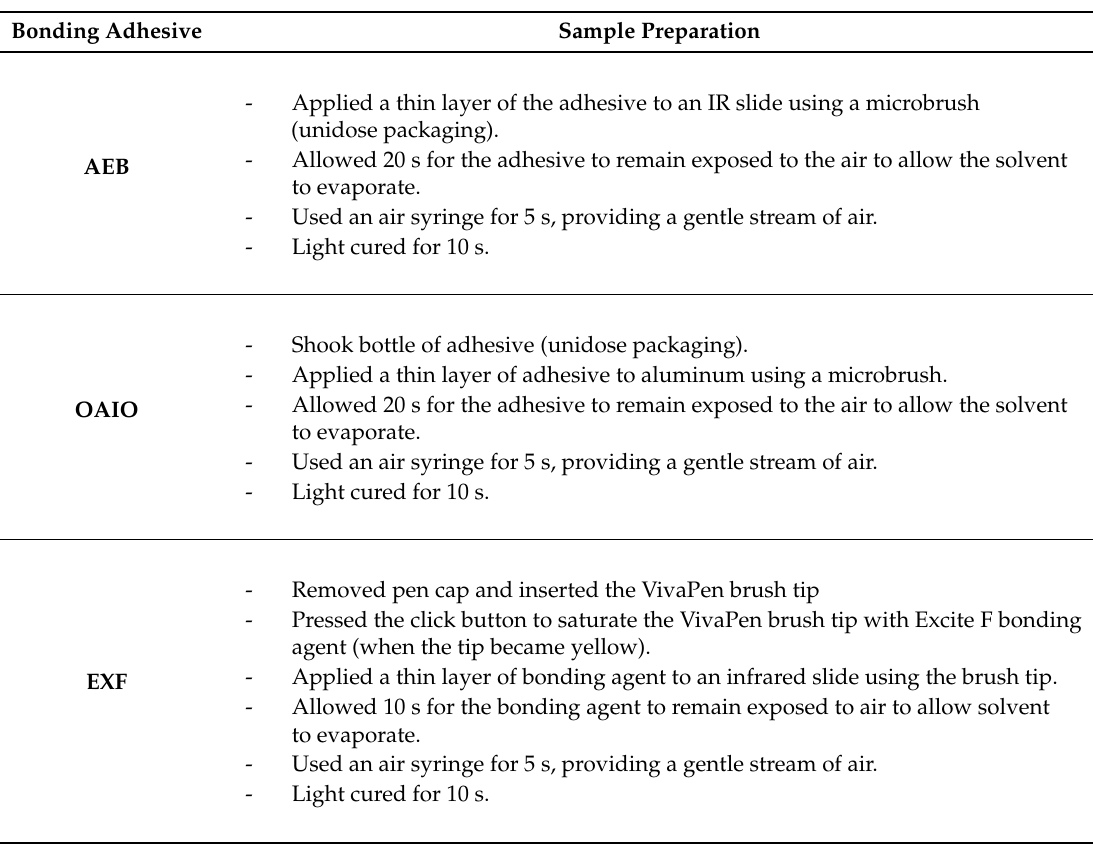
Table A2. Sample preparation according to manufacturer’s